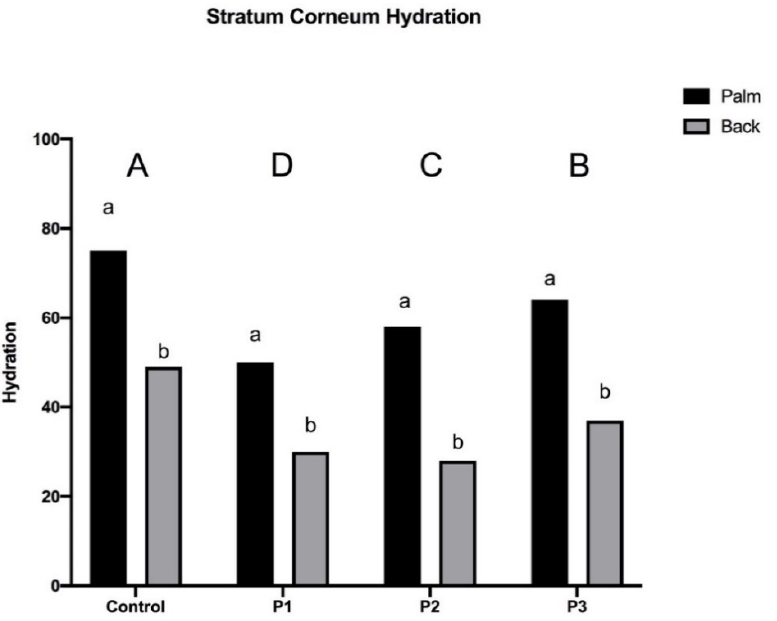
Figure 5. Mean ( n = 8) of front and back hydration of different volunteers in response to three products at 3 days after treatment. Values are expressed as mean of measurement replicates ( n = 3). Different uppercase letters indicate statistically significant differences among the hydration in all different products’ treatments. Different lowercase letters indicate statistically significant differences among the hydration in the single product ( p ≤ 0.05).